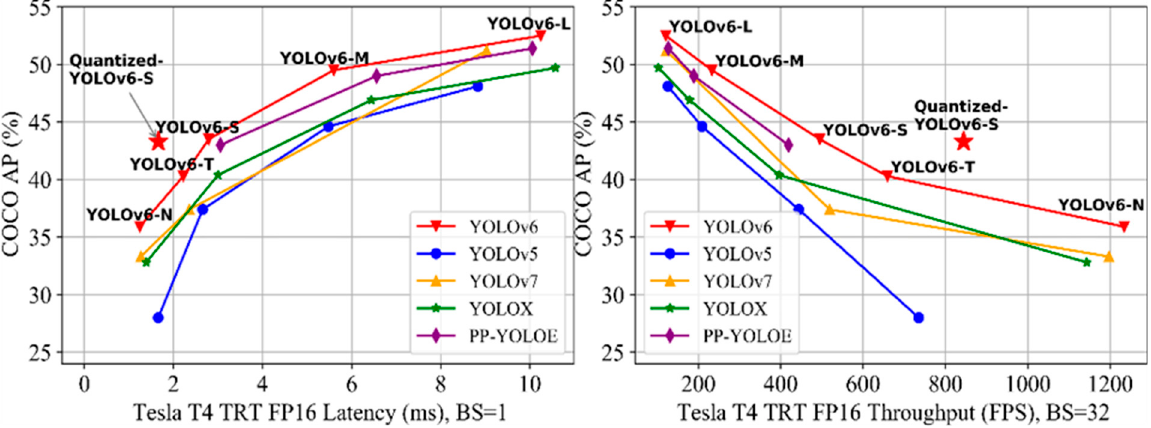
Figure 4. YOLOv6 accuracy comparisons with other YOLOv detectors [41].